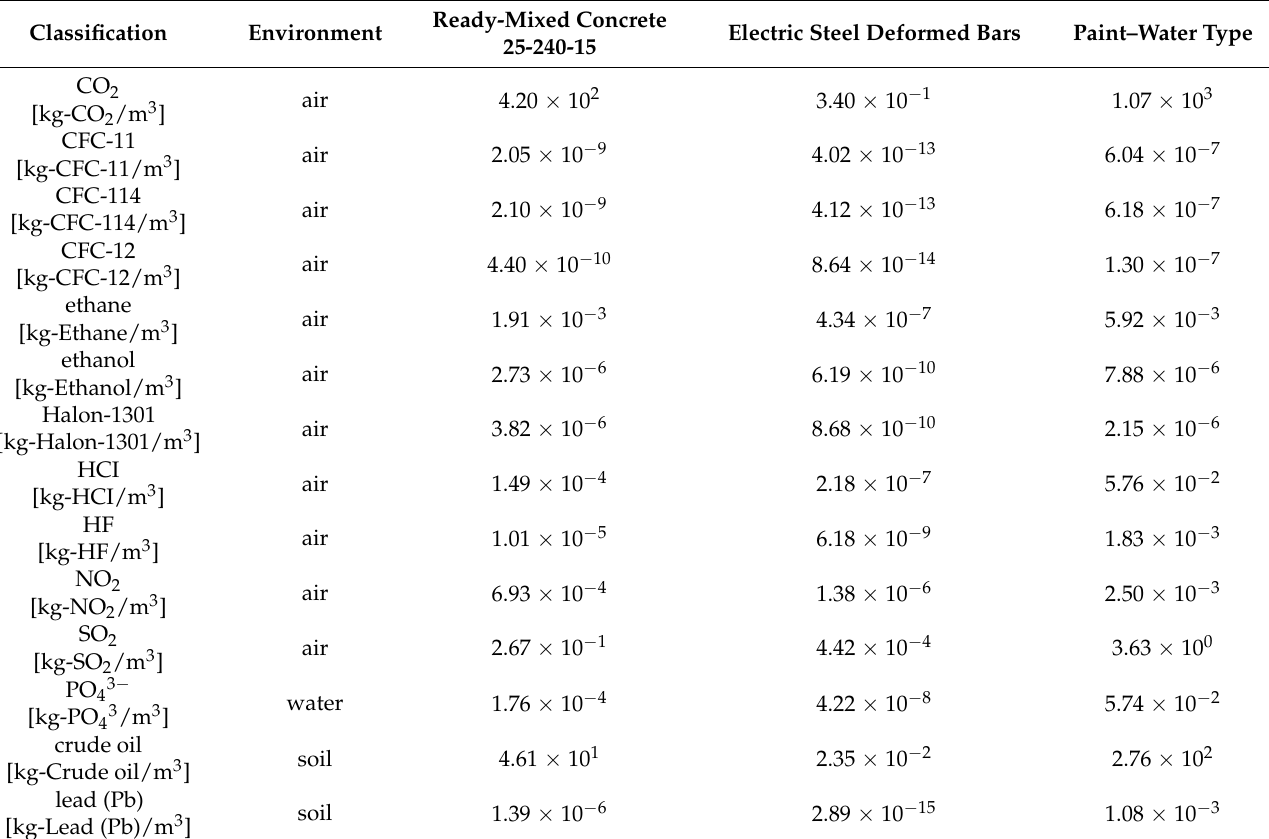
Table 3. Classification of building materials in the LCI DB [16] (CO 2 : carbon dioxide, CFC: chloroflu-